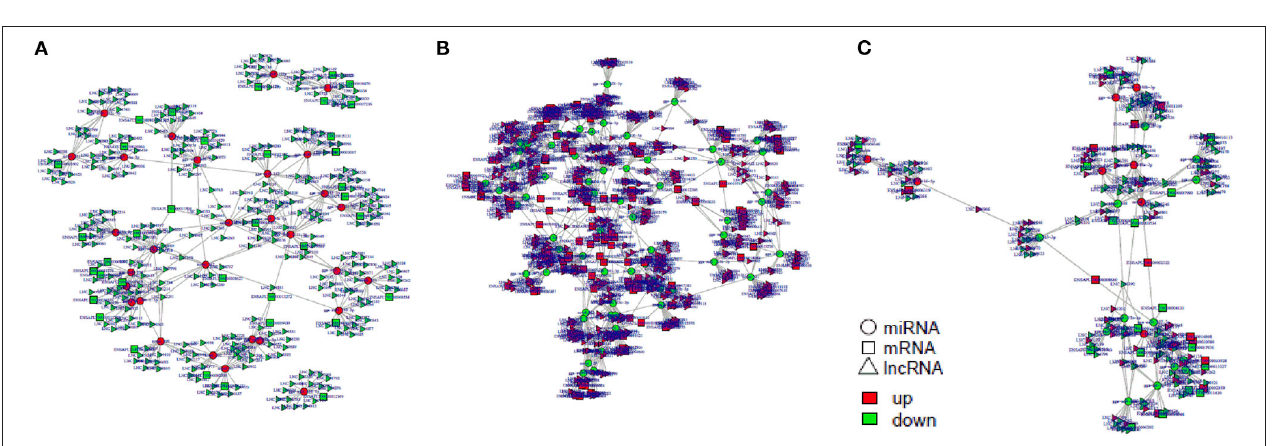
Protective cellular immune responses play a key role in controlling S . Enteritidis infections while supporting sustained egg